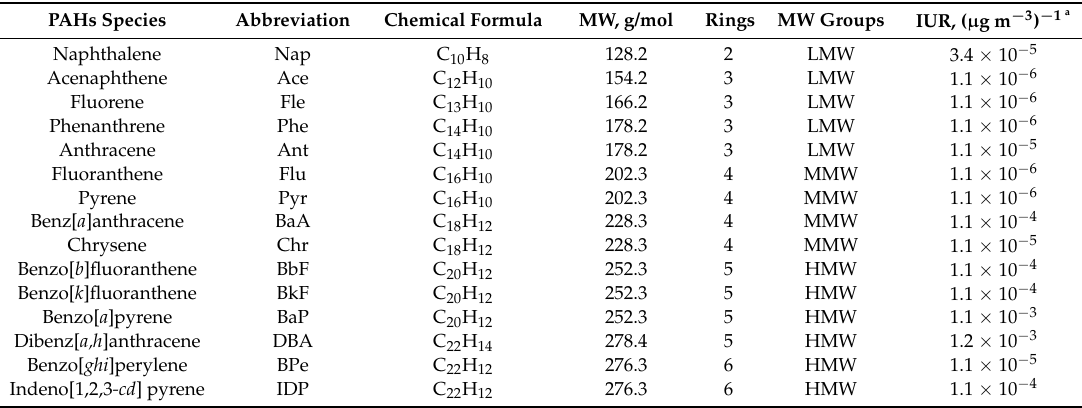
Table 3. Inhalation unit risk (IUR) for the studied